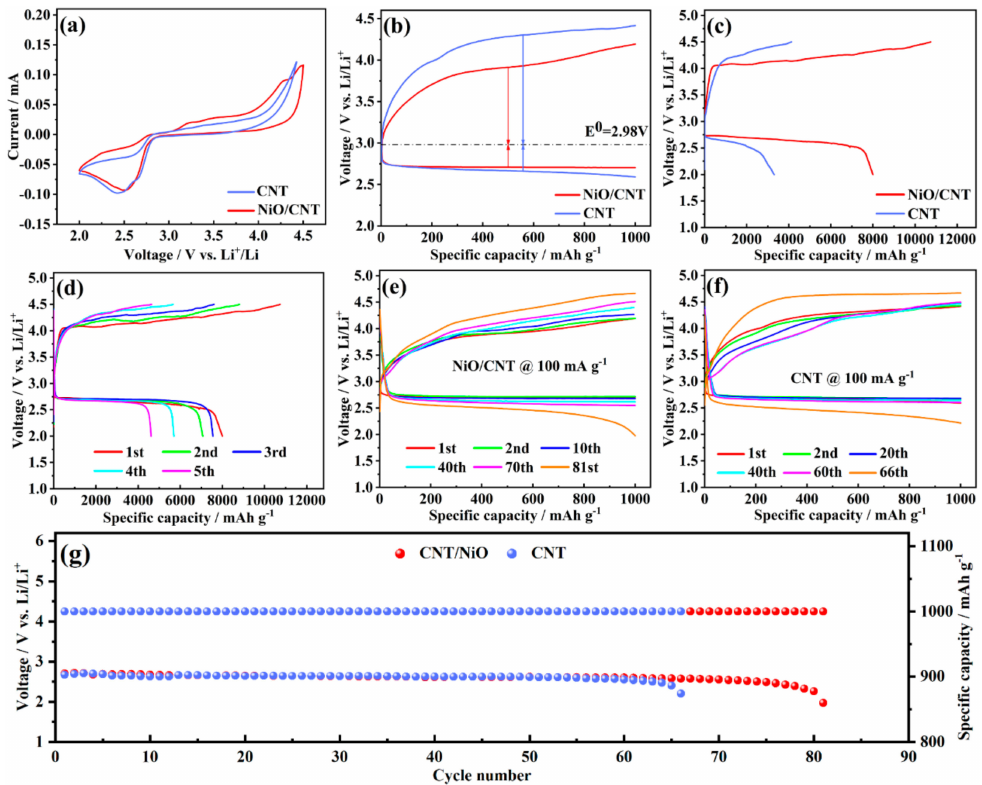
Figure 4. ( a ) The CV curves and ( b ) discharge–charge curves at first cycle of Li-O 2 batteries with NiO/CNT and CNT catalysts; ( c ) full discharge–charge curves of NiO/CNT and CNT catalysts at a current density of 100 mA g − 1 ; ( d ) the cycling stability of full discharge–charge battery with the NiO/CNT catalyst at a current density of 100 mA g − 1 ; ( e , f ) the cycling curves of NiO/CNT and CNT catalysts with a limited specific capacity of 1000 mA h g − 1 at a current density of 100 mA g − 1 ; ( g ) cycling stability of Li-O 2 batteries with NiO/CNT and CNT cathodes at a current density of 100 mA g − 1 . The charge–discharge curves of the first cycle were used to compare the overpotential of two materials under a limited capacity at 1000 mA h g − 1 . The Li-O 2 battery with the NiO/CNT cathode exhibited an obvious lesser overpotential of 1.2 V, while the overpoten- tial with the CNT cathode was 1.64 V (Figure 4b). The overpotential of OER decreased from 1.32 V to 0.93 V, and the overpotential of ORR decreased from 0.32 V to 0.27 V. Therefore, NiO/CNT had higher activity than CNT in ORR and OER processes. Additionally, using NiO/CNT and CNT catalysts as cathode materials, full discharge–charge tests in the first cycle of batteries were performed with a current density of 100 mA g − 1 (Figure 4c). In the discharge stage, the battery with the NiO/CNT cathode catalyst showed a specific